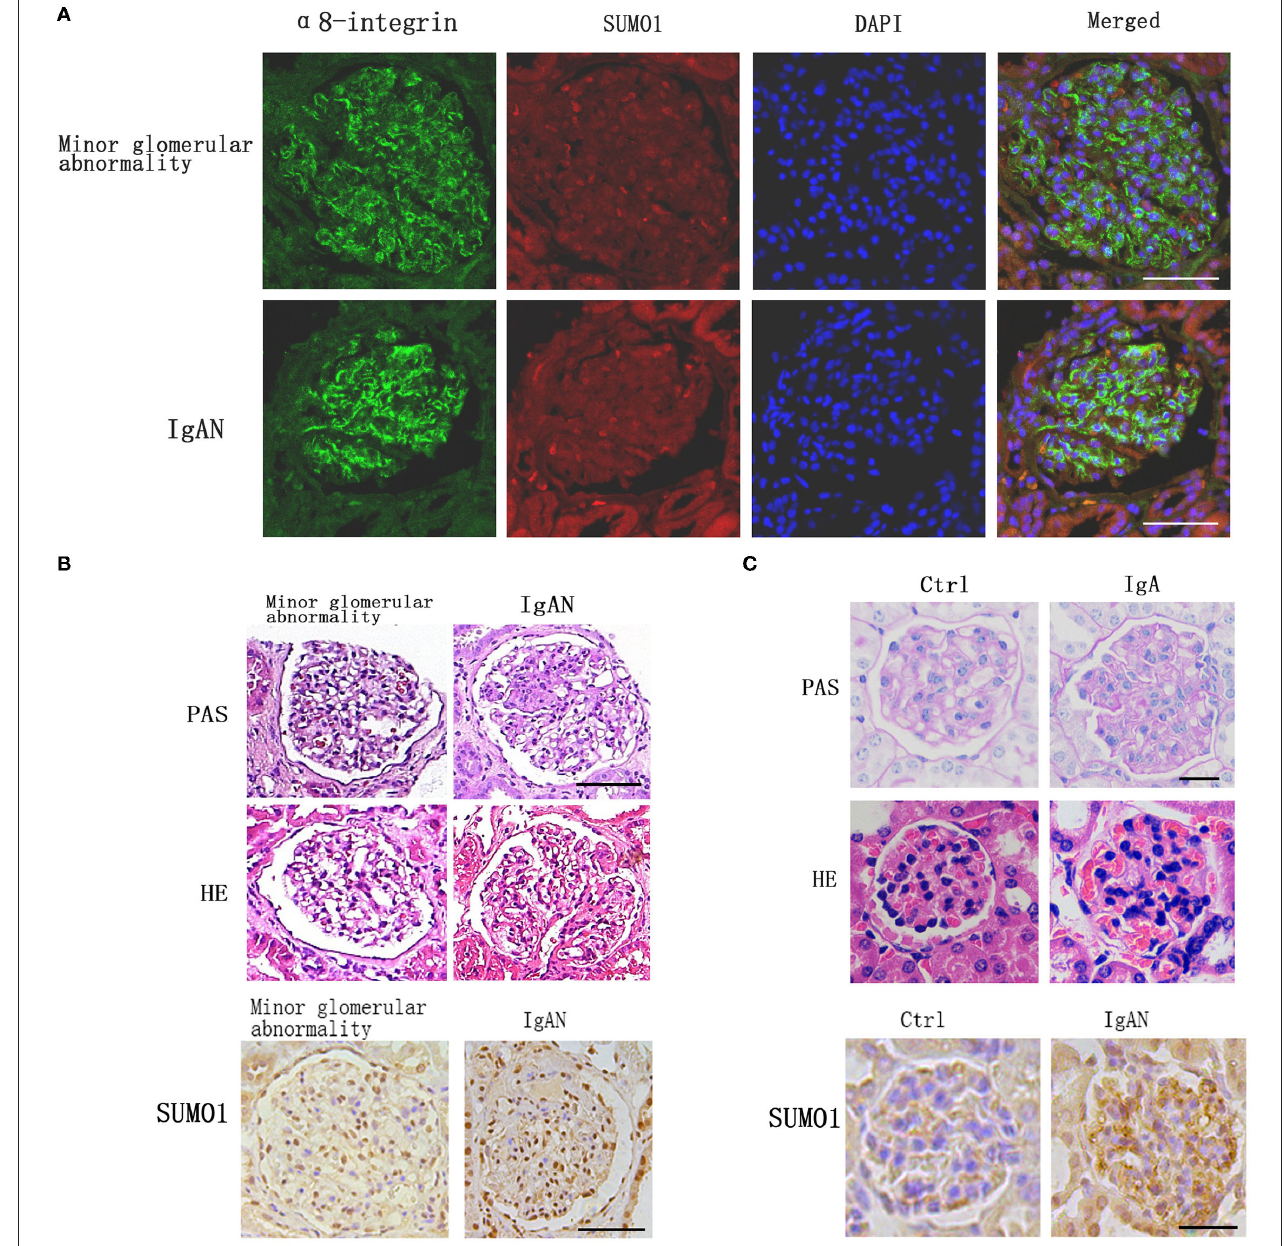
FIGURE 1 | Comparison of SUMO1 expression between IgA nephropathy kidney tissues and adjacent tissues. (A) Immunofluorescence staining showed the intraglomerular localization of SUMO1, scale bar 100 µ m. (B) PAS and HE staining of human kidney tissue. Immunohistochemistry staining for SUMO1 indicated the expression of SUMO1 were up-regulated in IgAN patients group than the minor glomerular abnormality control group, scale bar 100 µ m ( n = 10 per group). (C) PAS and HE staining of mouse model kidney tissue. Immunohistochemistry staining for SUMO1 showed the expression of SUMO1 were up-regulated in the mesangial area of IgAN mouse model, scale bar 20 µ m ( n = 11 per group).